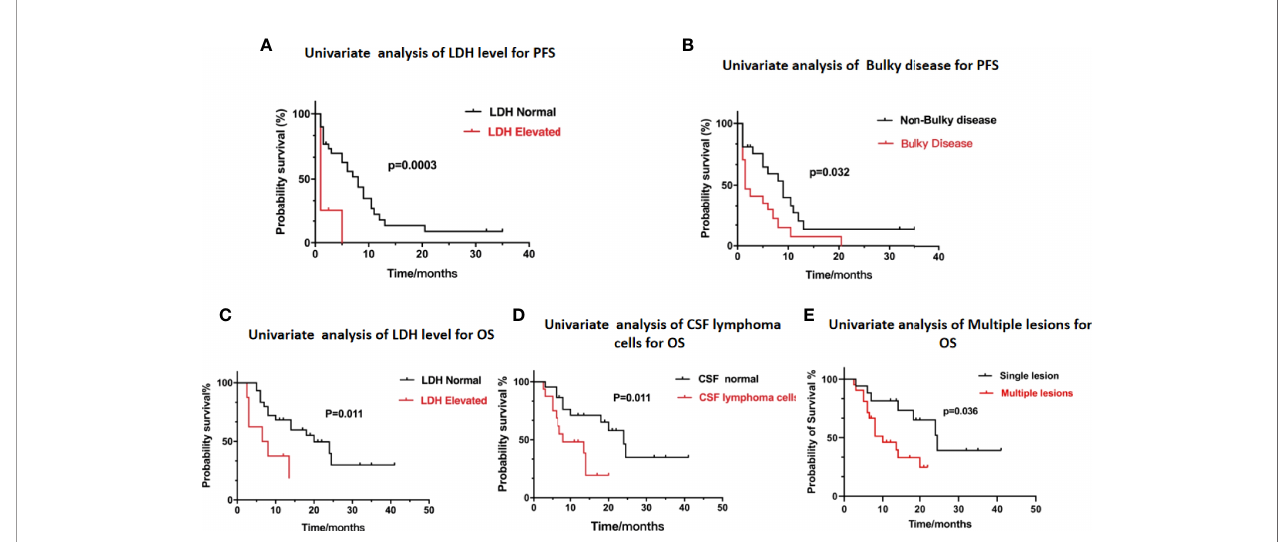
FIGURE 4 | Kaplan-Meier survival curve and prognosis analysis. (A) Univariate analysis of LDH level for PFS. (B) Univariate analysis of Bulky disease for PFS. (C) Univariate analysis of LDH level for OS. (D) Univariate analysis of CSF lymphoma cells for OS. (E) Univariate analysis of Multiple lesions for